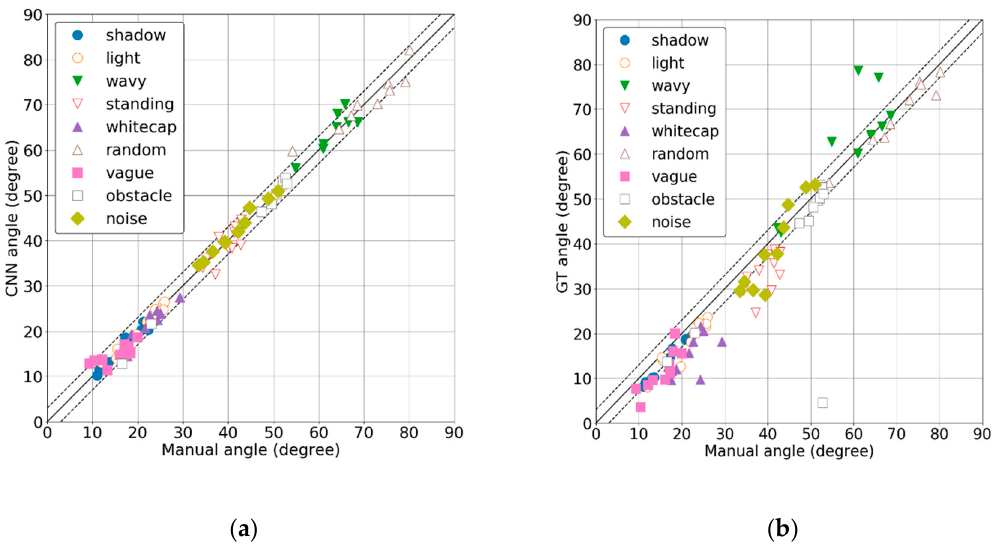
Figure 9. Comparison with manually confirmed angles: ( a ) CNN; ( b ) gradient tensor method.